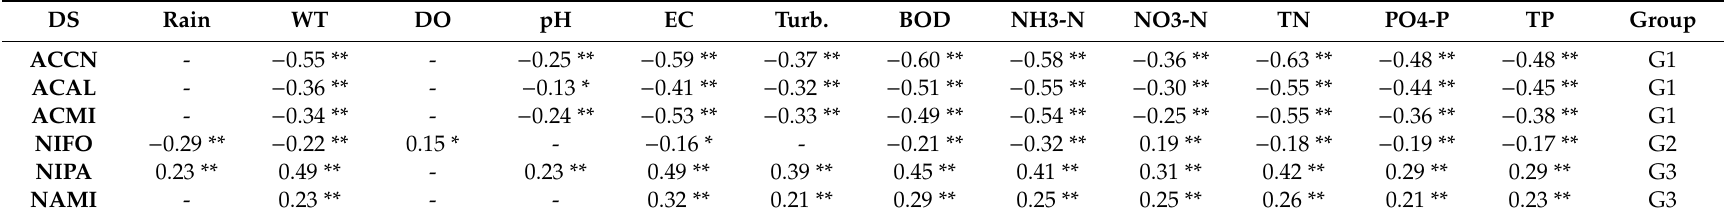
Table 3. The correlation coe ffi cients between the dominant diatom species (DS) and water quality parameters before and after the monsoon in the Hantangang River, from 2012 to